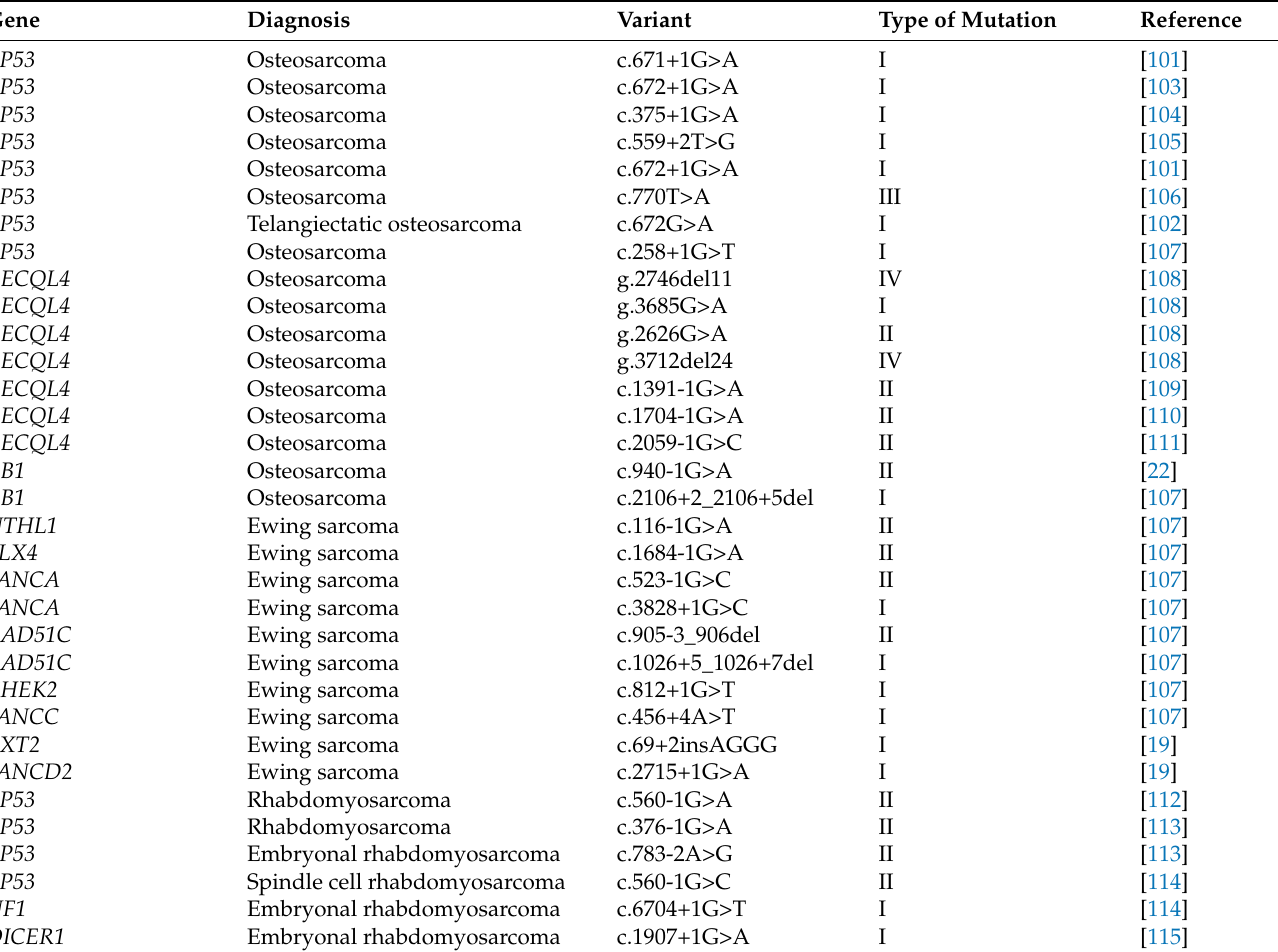
Table 3. Germline pathogenic splice variants found in pediatric patients with